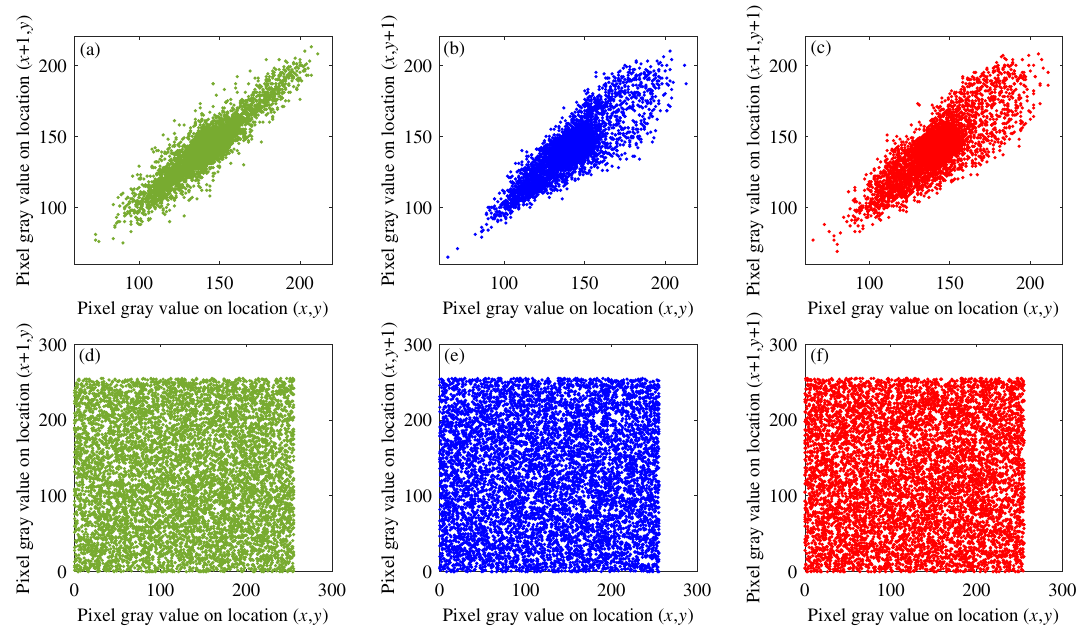
Figure 17. Correlation images of plaintext and ciphertext in various directions. ( a ) Correlation of plaintext in horizontal direction. ( b ) Correlation of plaintext in vertical direction. ( c ) Correlation of plaintext in Diagonal direction. ( d ) Correlation of ciphertext in horizontal direction. ( e ) Correlation of ciphertext in vertical direction. ( f ) Correlation of ciphertext in Diagonal direction.